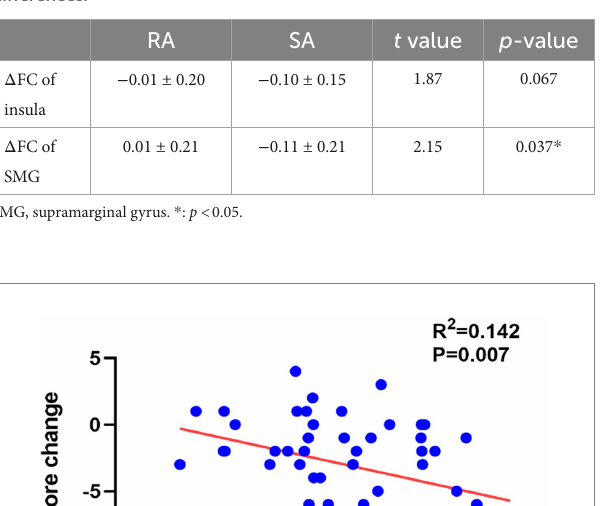
TABLE 6 Intergroup comparisons of Δ FC values in brain regions with